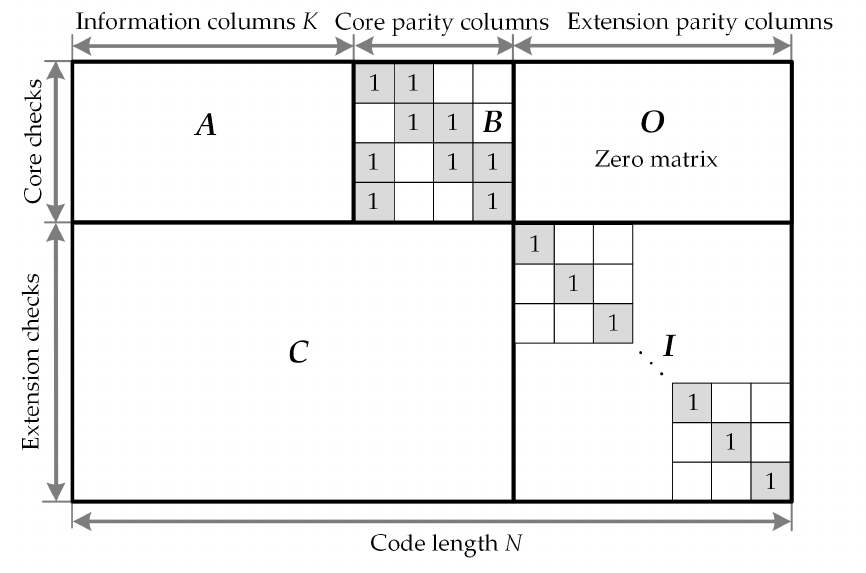
Figure 1. Sketch of base parity check structure for the 5G NR QC-LDPC codes.